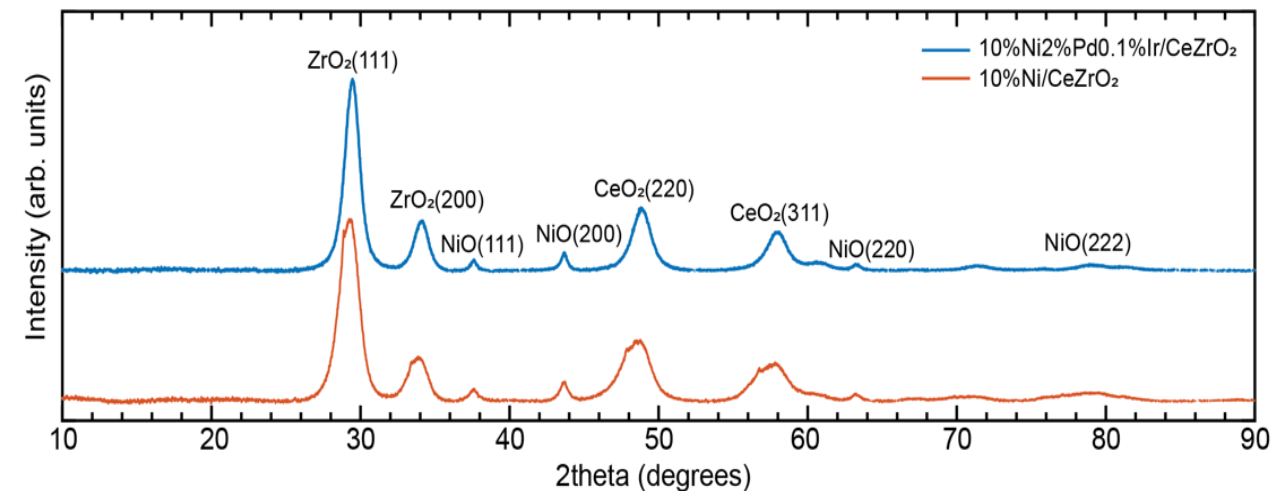
Figure 1. XRD pattern of 10 wt%Ni 2 wt%Pd 0.1 wt%Ir/CeZrO 2 and 10 wt%Ni/CeZrO 2 catalysts. Table 1. BET-BJH results of fresh and spent 10 wt%Ni 2 wt%Pd 0.1 wt%Ir/CeZrO 2 and 10 wt% Ni/CeZrO 2 catalysts. Catalyst BET Surface Area (m 2 /g) Pore Volume (cm 3 /g cat ) Pore Size